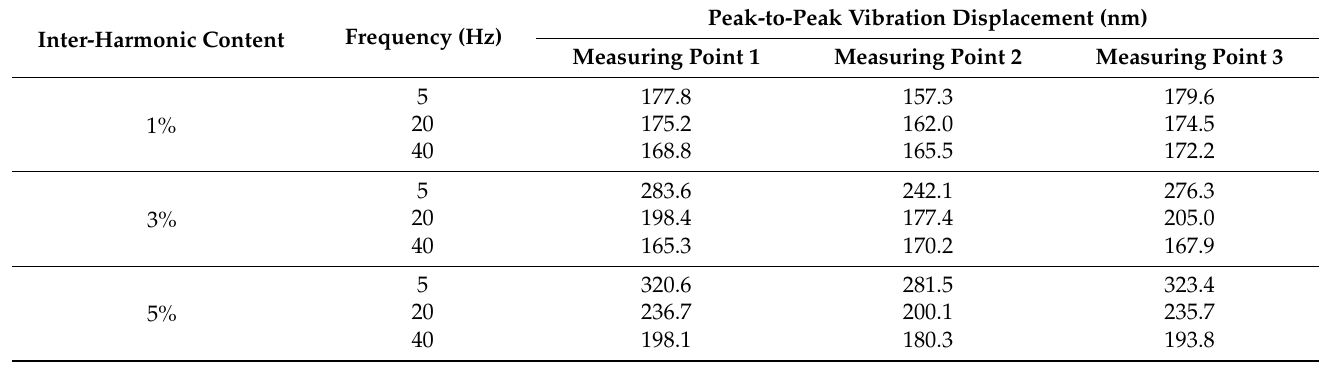
Table 4. Peak-to-peak vibration displacement with voltage amplitude of 41.18 V.